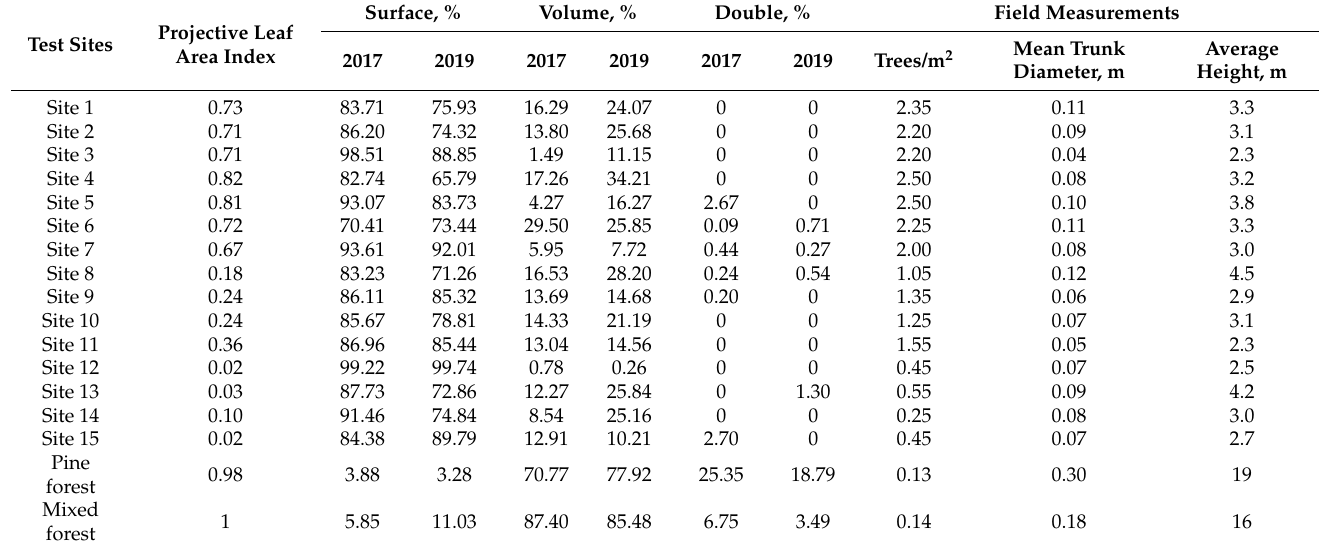
Table 1. H– α classification statistics for reforestation test sites and control pine and mixed forest